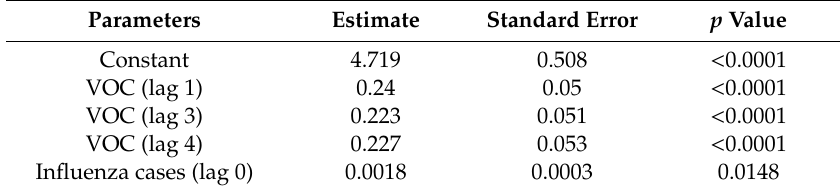
Table 2. Parameter estimates of final multivariate model of hospitalizations for